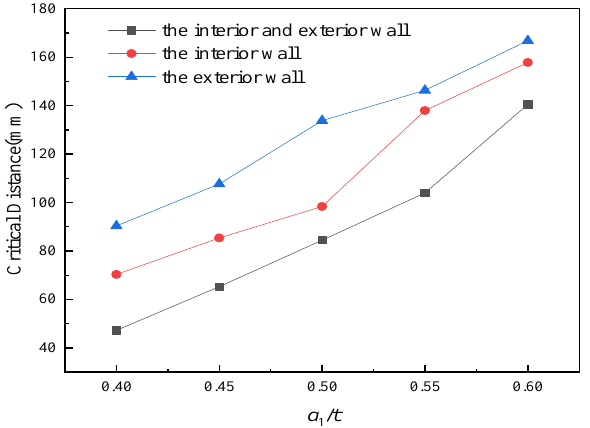
Figure 8. Comparative analysis of the critical distance of defect depth.